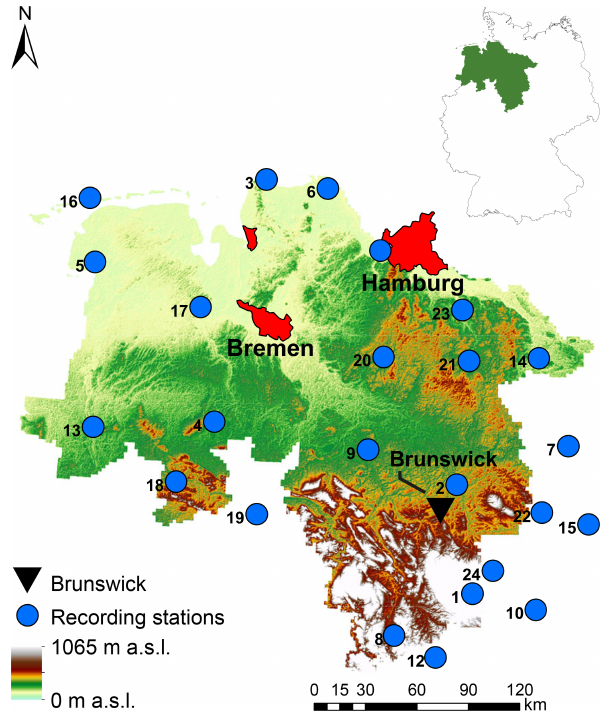
Figure 1. Study area of Lower Saxony (and its location in Germany) with 24 recording stations and the cities of Hamburg, Bremen and Brunswick for orientation (based on the digital elevation model of the Shuttle Radar Topography Mission – Jarvis et al.,